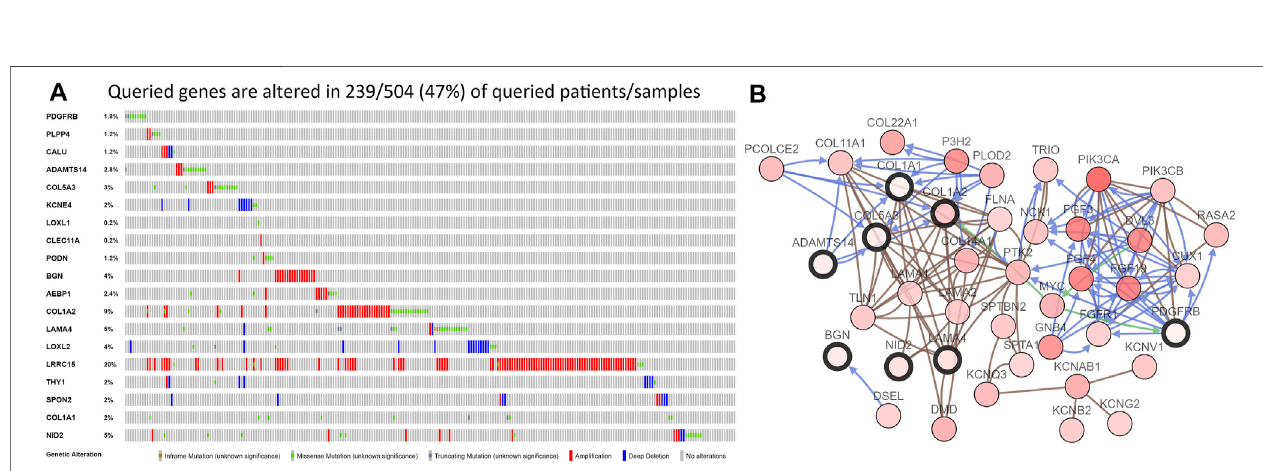
Frontiers in Genetics |